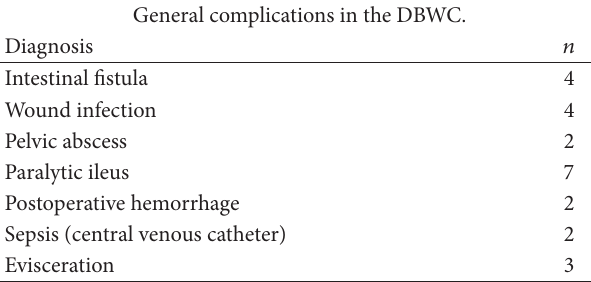
Table 4: General complications in DBWC patients. The literature